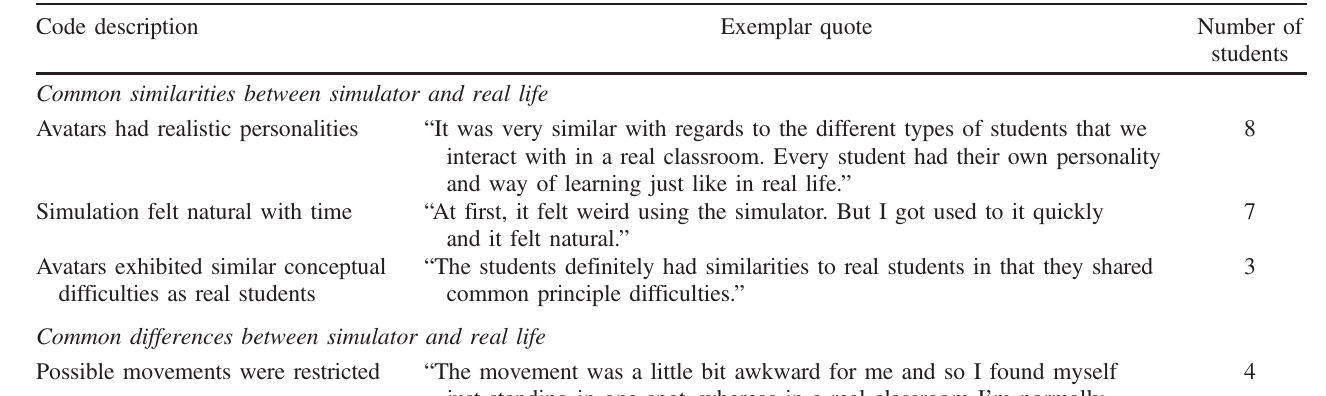
TABLE V. Suspension of disbelief codes. Examples of quotes from the LAs ’ reflections on the simulator and the number of LAs exhibiting each